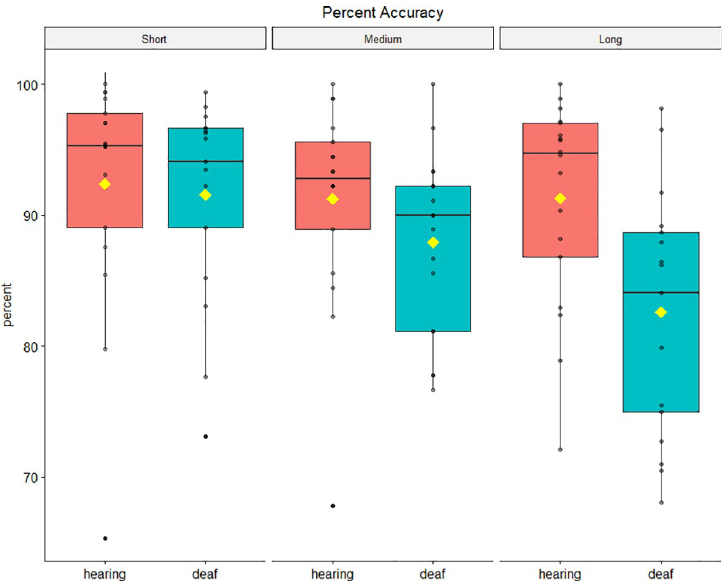
Fig 3. Percent accuracy per SOA condition. Fig 3 was created using the ggpubr package in R [46]. Horizontal lines indicate medians; yellow rhombuses indicate means.